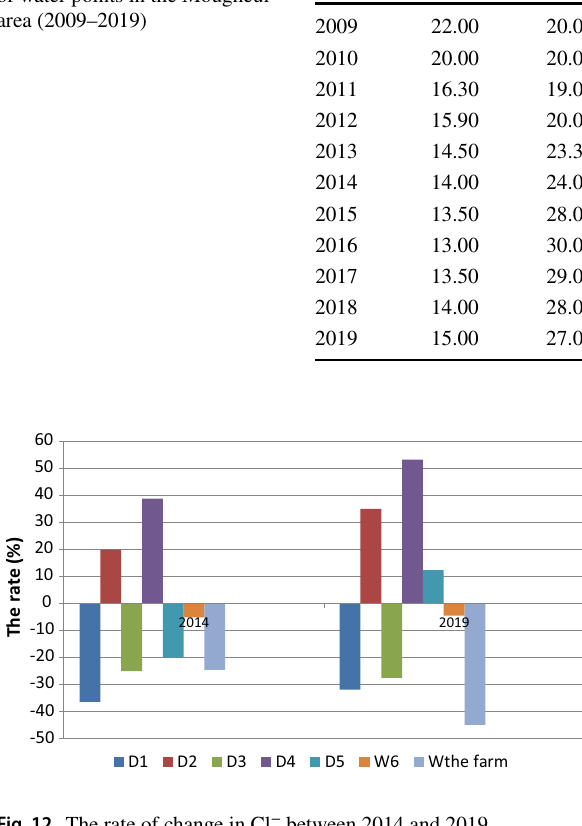
Fig. 12 The rate of change in Cl − between 2014 and 2019